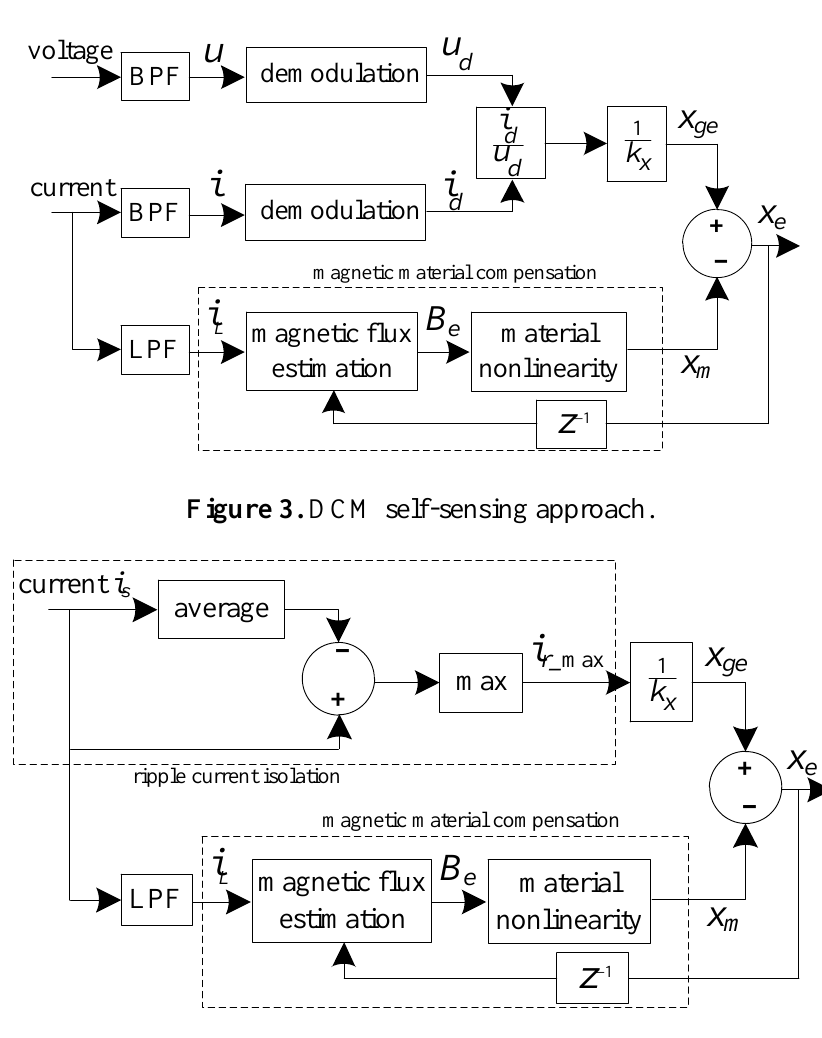
Figure 2. Modulation self-sensing algorithm.